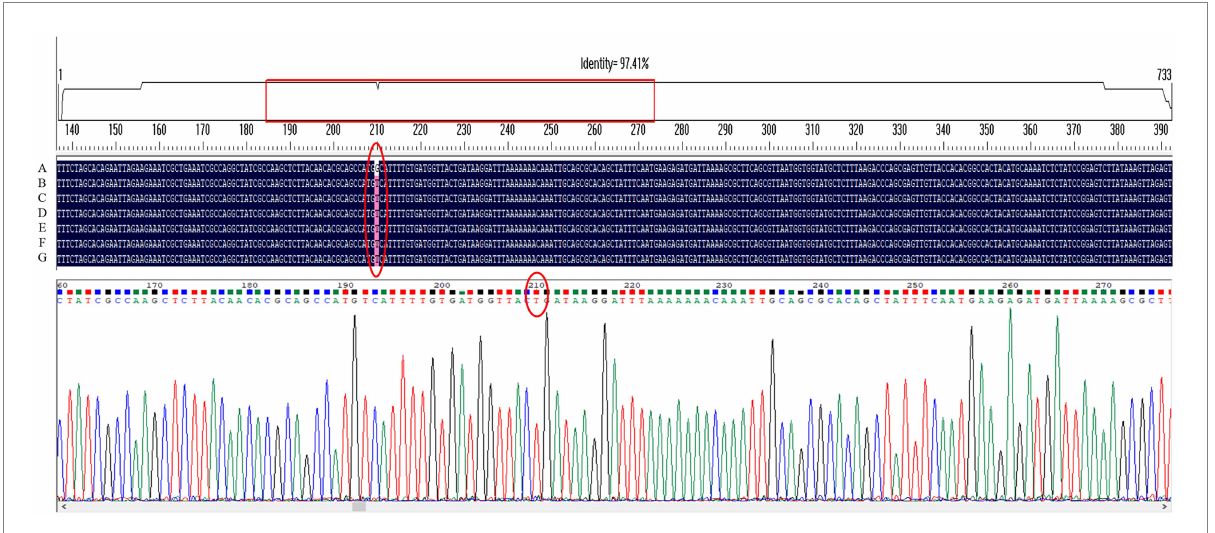
FIGURE 2 G210T point mutation in the MTZ resistance-related gene rdxA of H. pylori 26,695–16R under different drug interventions. A, H. pylori 26,695; B, H. pylori 26,695–16R; C, Treated with Pa β N (20 μ g/ml); D, Treated with CCCP (1 μ g/ml); E, Treated with JWC 16 μ g/ml; F, Treated with JWC 32 μ g/ml; G, Treated with JWC 64 μ g/ml.